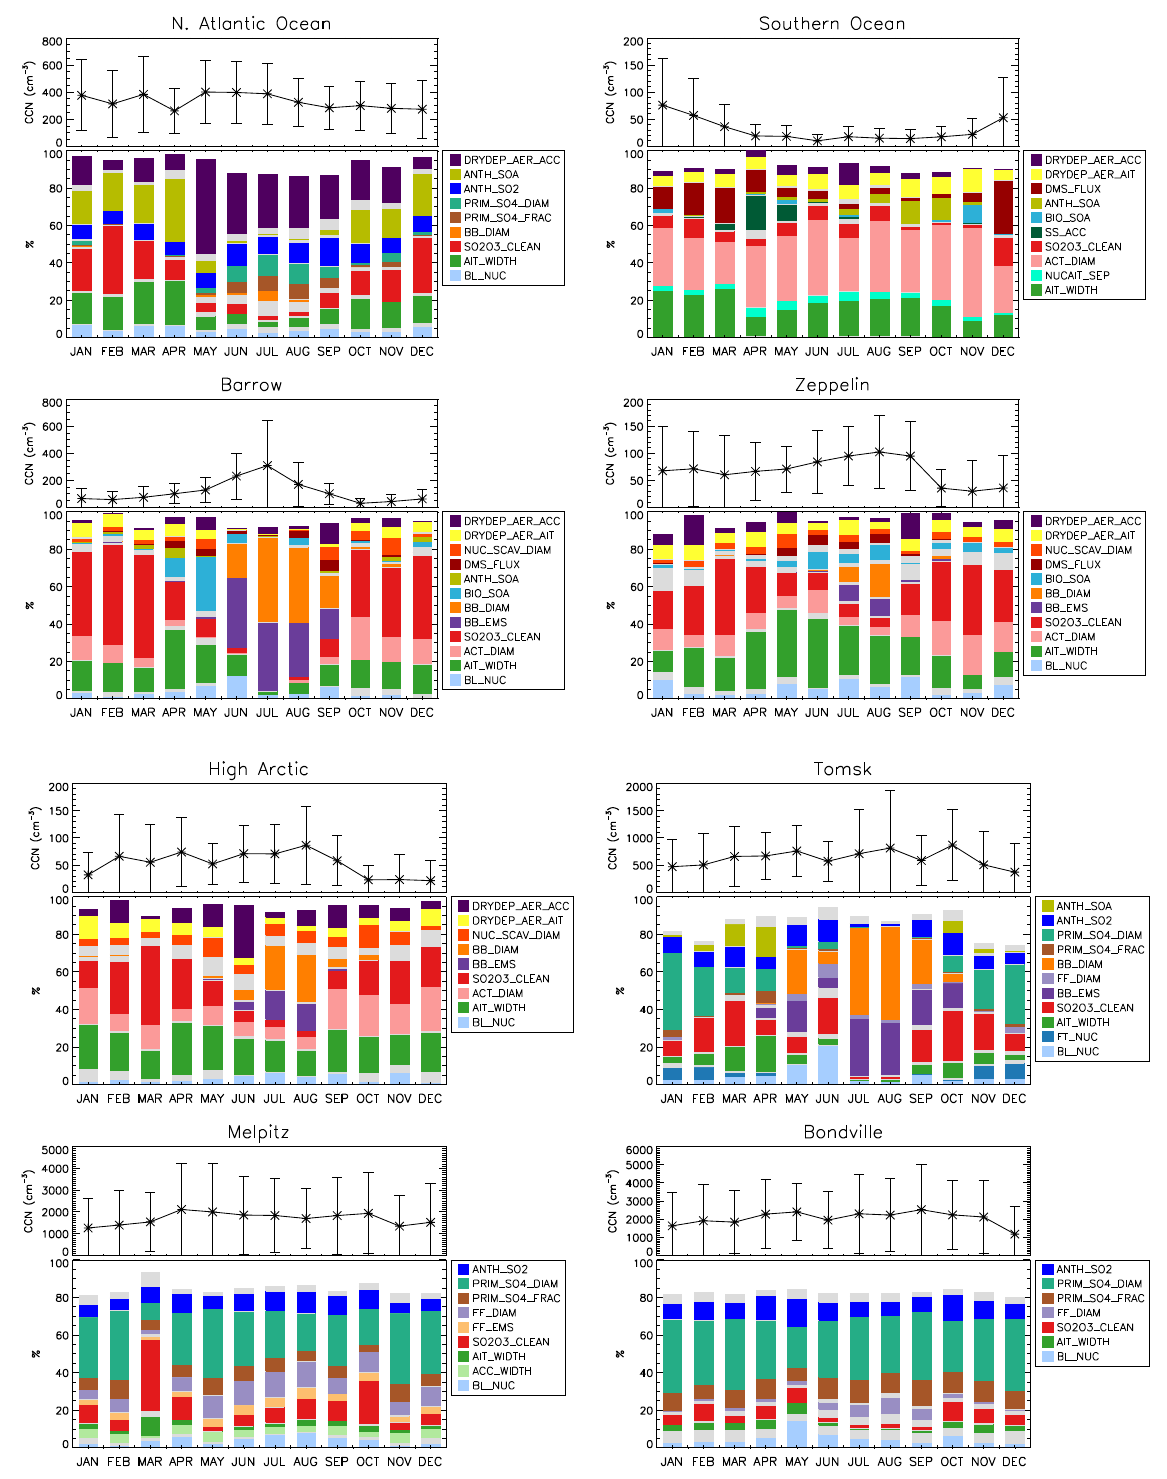
Fig. 9. Time series of the mean emulator-predicted CCN concentration with 2 σ CCN error bars (upper figure) and the main effect sensitivities (the percentage of CCN variance due to each parameter) (lower figure) across the year 2008 for the 13 locations in Sect. 6.3.6 and Fig. 9. Parameters with a main effect ≥ 5% are shown in colour, and parameters with a main effect < 5% are shown in grey. The white space below 100% shows the fraction of variance due to interactions between the parameters since with no interactions the main effects sum to